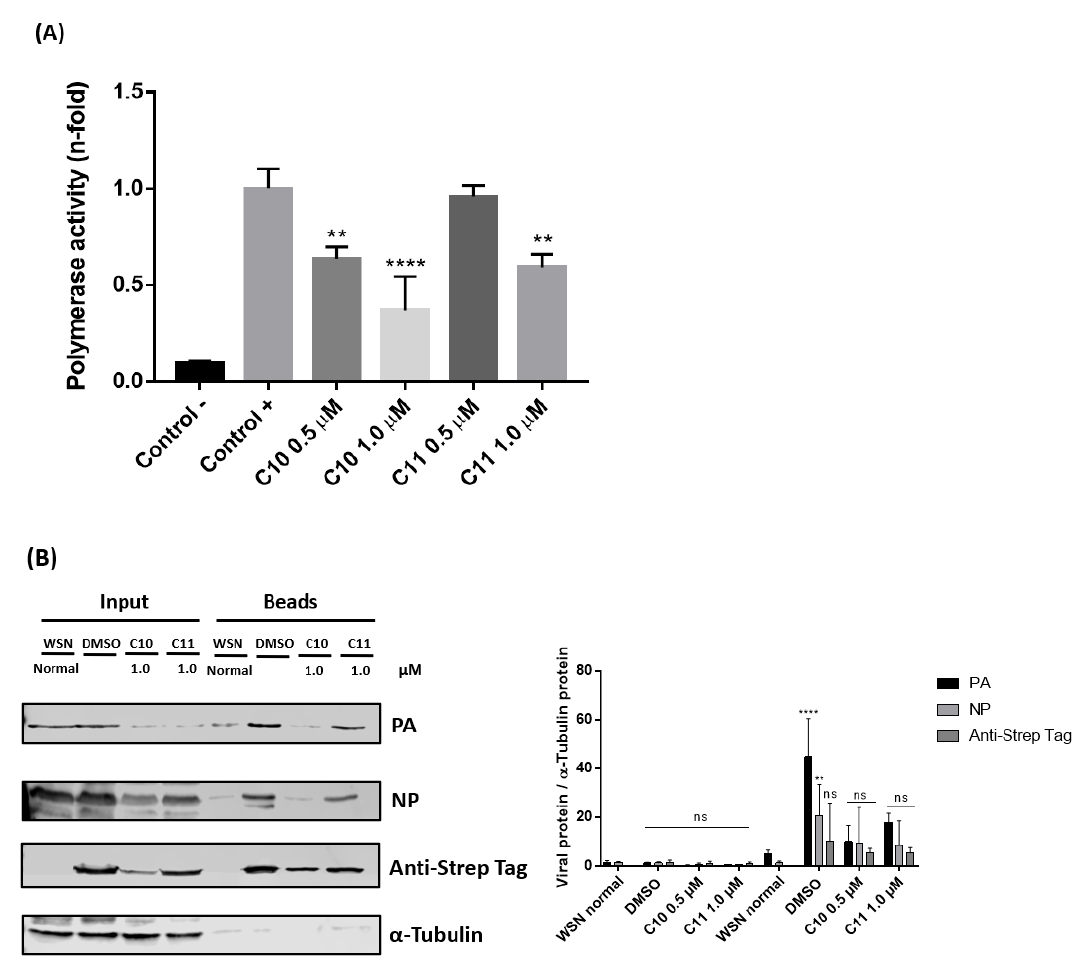
Figure 5. E ff ects of C10 and C11 on influenza A virus polymerase activity. ( A ) MDCK cells were transfected with plasmids expressing PB1, PB2, PA, and NP (PPPN), along with a plasmid-encoding luciferase under control (+) of viral promoter sequences. As negative control ( − ), the transfection mix lacking the PB2-encoding plasmid (PPN) was used. Medium was changed 4 h post-transfection (p.t.), C10 and C11 were added at 0.5 and 1.0 µ M and incubated. After 24 h p.t., cells were lysed and the results were calculated as n-fold of luciferase activity in PPN-transfected C10 and C11 -treated cells, which was arbitrarily set to 1, and represent the mean ± SD of three independent experiments. ** p < 0.01 and **** p < 0.0001 vs. positive control, one-way ANOVA, post hoc test Dunnet. ( B ) E ff ects of C10 and C11 cardenolide derivatives on recombinant influenza A virus (Strep-PB2-WSN) protein expression, when bound or not to beads. Subcellular fractions were added to the beads and incubated overnight at 4 ◦ C. After, beads were pelleted and Western blot analyses were performed using specific antibodies polymerase complex (PA, PB1, NP, Anti-Strep TagM1, and NS1) proteins. Equal protein loading was confirmed by probing for α -Tubulin. WSN normal = cells infected with influenza A virus ((strain A / WSN / 33 (H1N1)) and not treated; DMSO = solvent control. The graph indicates the ratio of each viral protein to α -Tubulin protein (ns = no significant, ** p < 0.01, and **** p < 0.0001 vs. the respective viral controls, two-way ANOVA, post hoc test